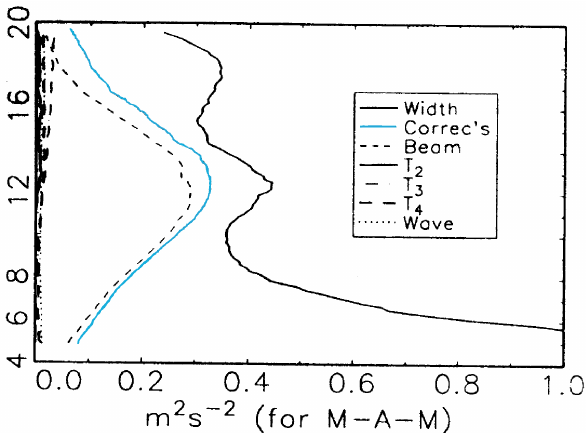
Fig. 3. Mean vertical profiles of the observed width with the correc- tions due to beam broadening, shear broadening and gravity-wave effects from Nastrom and Eaton